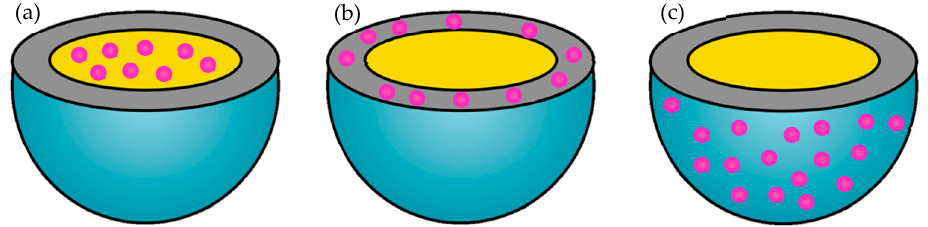
Figure 6. Drug distribution in solid lipid nanoparticles. Possible ways of incorporation of a drug (pink) in a SLN: ( a ) homogeneous dispersion in the lipid matrix, ( b ) incorporation in the shell of the matrix, or ( c ) distribution in the outer shell.